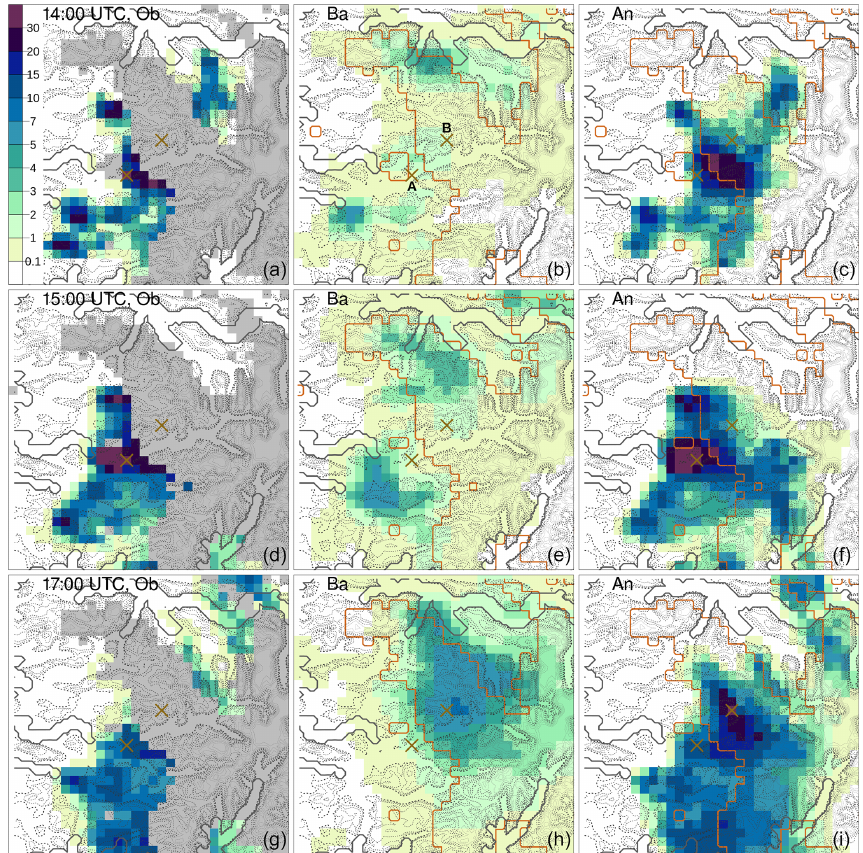
Figure 12. Hourly precipitation totals (in mmh − 1 ) over Sogn og Fjordane (see Fig. 7) for 30 July 2019 at 14:00UTC (a–c) , 15:00UTC (d–f) , and 17:00UTC (g–i) . The panels labeled with Ob ( a , d , and g ) show the aggregated observed values, as in Fig. 9. The panels with Ba ( b , e , and h ) show the background ensemble mean. The panels with An ( c , f , and i ) show the analysis expected value. The crosses mark the A and B points of Fig. 7, which are also shown in (b) . The dark orange lines in the panels for Ba and An delineate the boundary of the gray area shown in the panels for Ob. The color scale is the same for all panels. The thick lines and the dashed lines have the same meaning as in Fig.